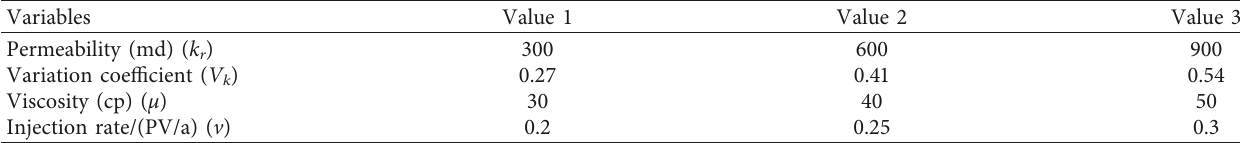
Figure 28: Pressure field of the numerical simulation model. Table 4: Values of influence factors in